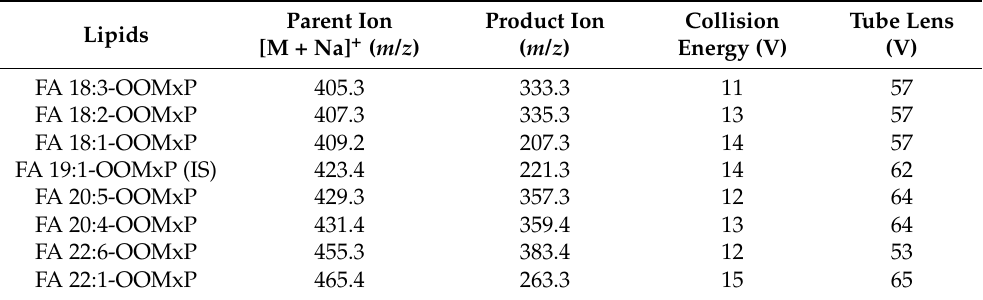
Table 1. Optimized SRM parameters for 2-methoxyprepene derivatized fatty acid hydroperoxides (FA: Fatty acid; MxP: